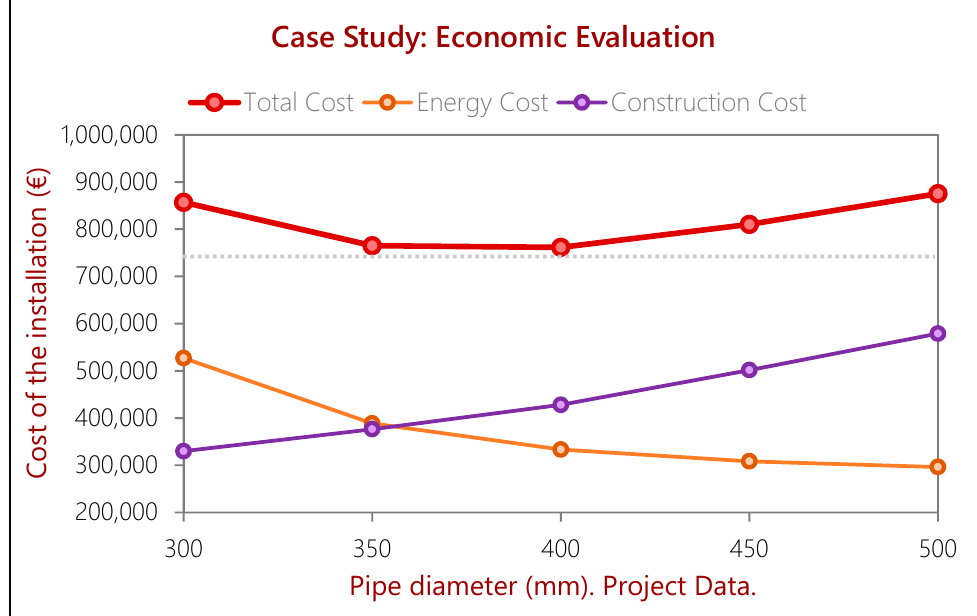
Figure 10. Economic evaluation of the case study at the Navas del Marqués. Table 4. Economic evaluation for the case study using the project prices for the pipes, once a diameter of 400 mm has been selected, to prove the least cost result.